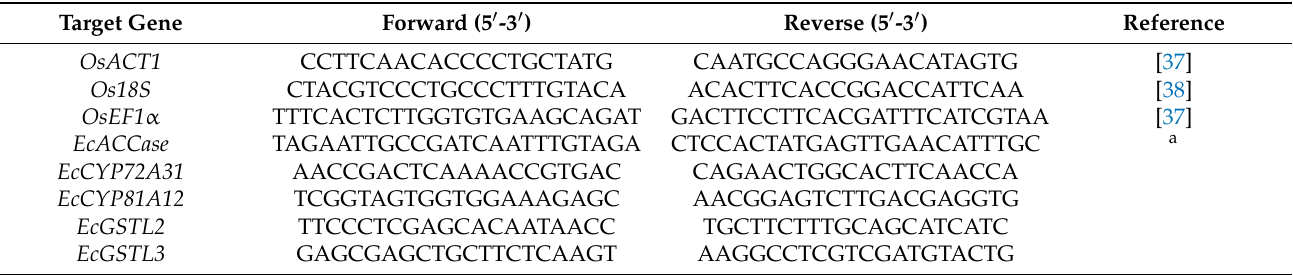
Table 1. Target and reference genes and primers used to study the gene expression in E. plana